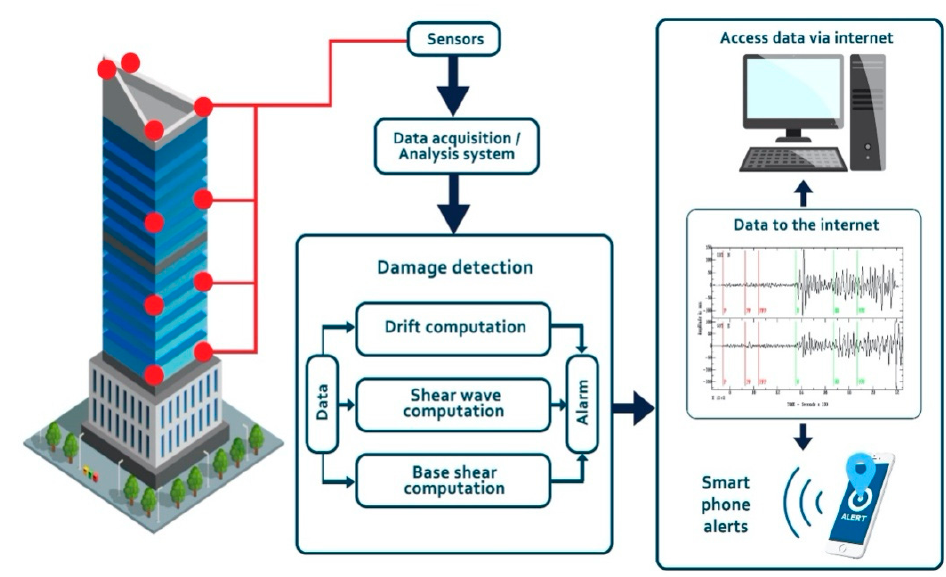
Figure 1. The operating principle of the SHM system in a multi-story building.